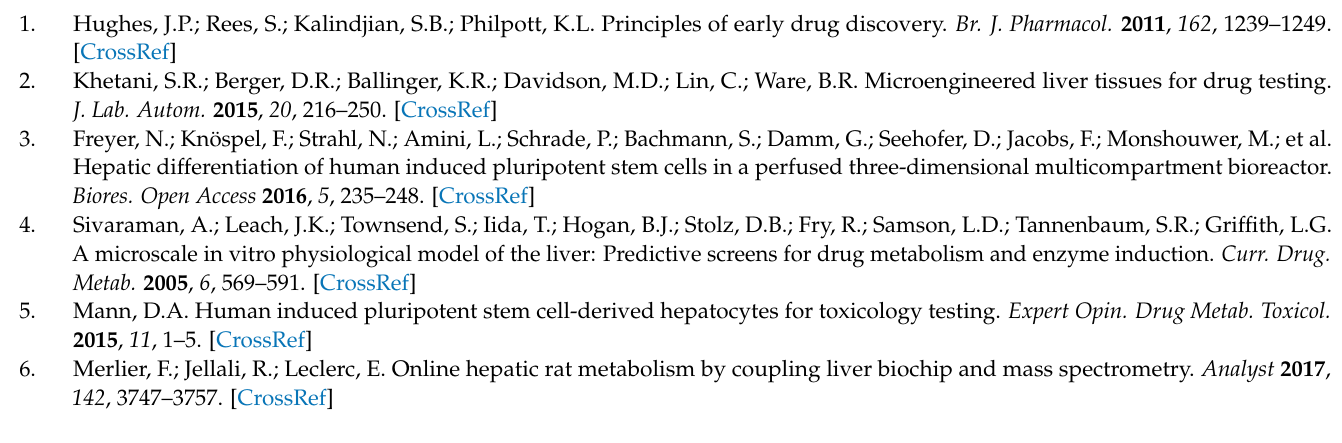
Figure S8: Albumin secreted by HepG2/C3A cells in 2D and 3D (hydroscaffold) static cultures and Figure S9: Morphologies and F-actin staining of HepG2/C3A inside a PDMS biochip (without